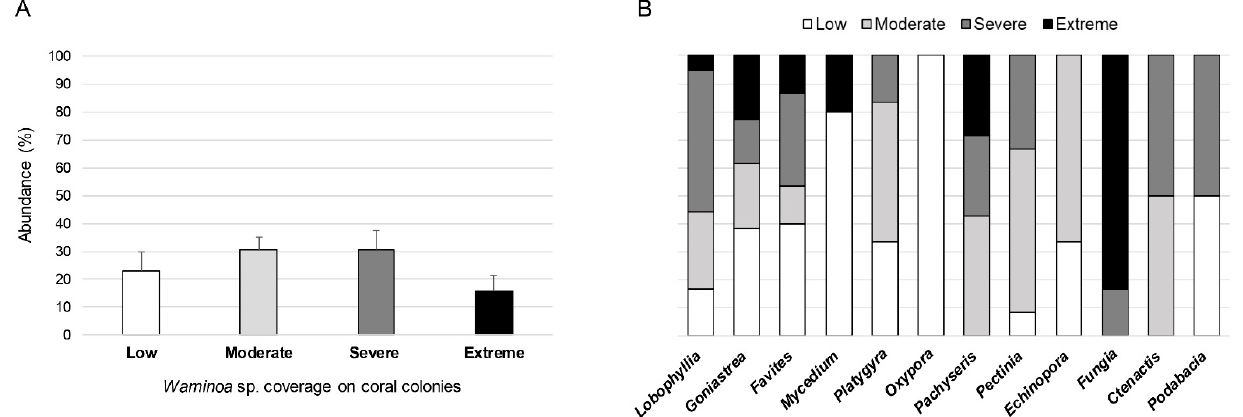
Figure 5. ( A ) Abundance (%; mean ± SE) of the coral colonies in association with Waminoa